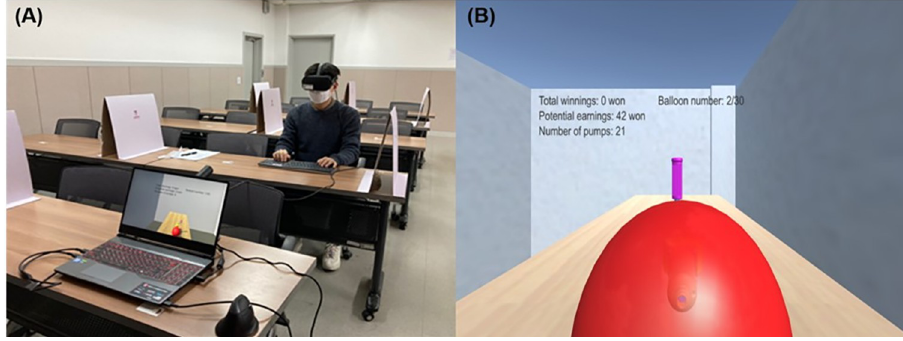
Fig 1. Setup of the experiment. (A) Setup of a VR BART (B) Screenshot of a VR BART trial.